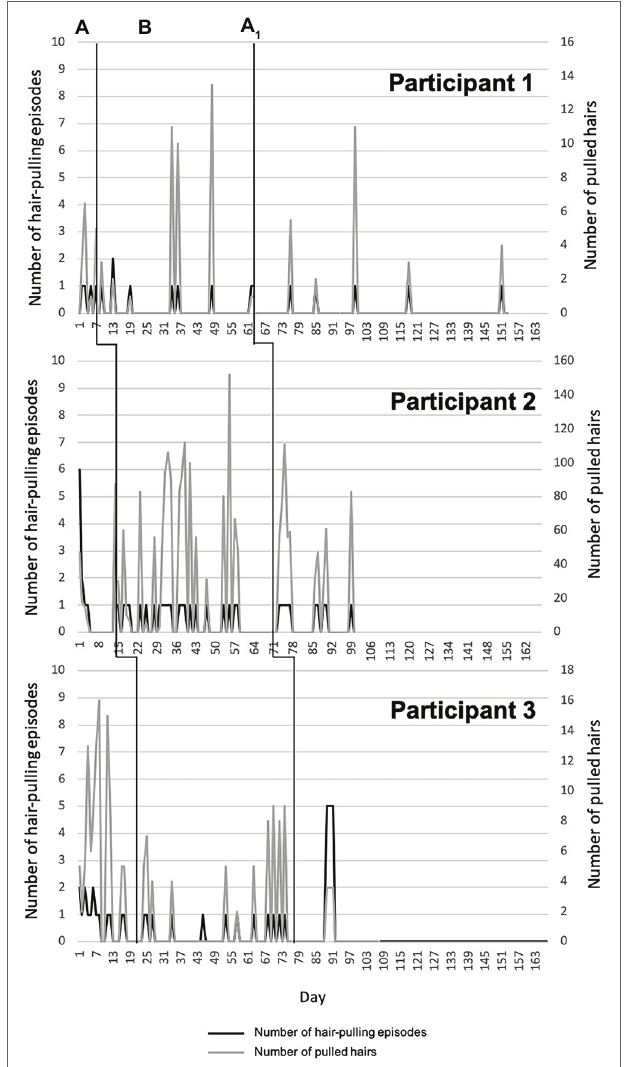
FIGURE 1 | Number of hair-pulling episodes and number of pulled hairs over time